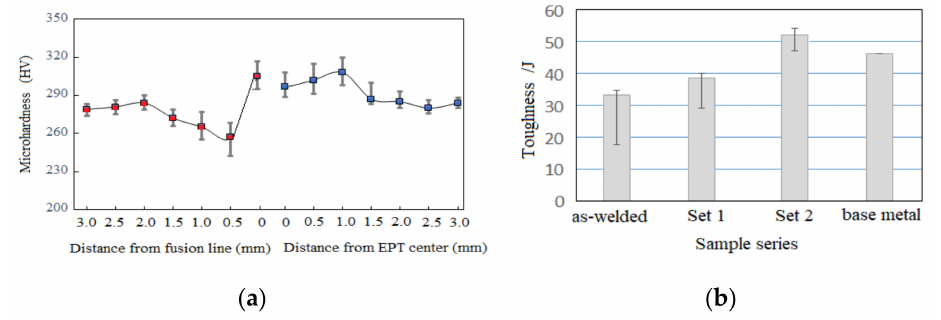
Figure 9. ( a ) Microhardness of Set 1; ( b ) impact